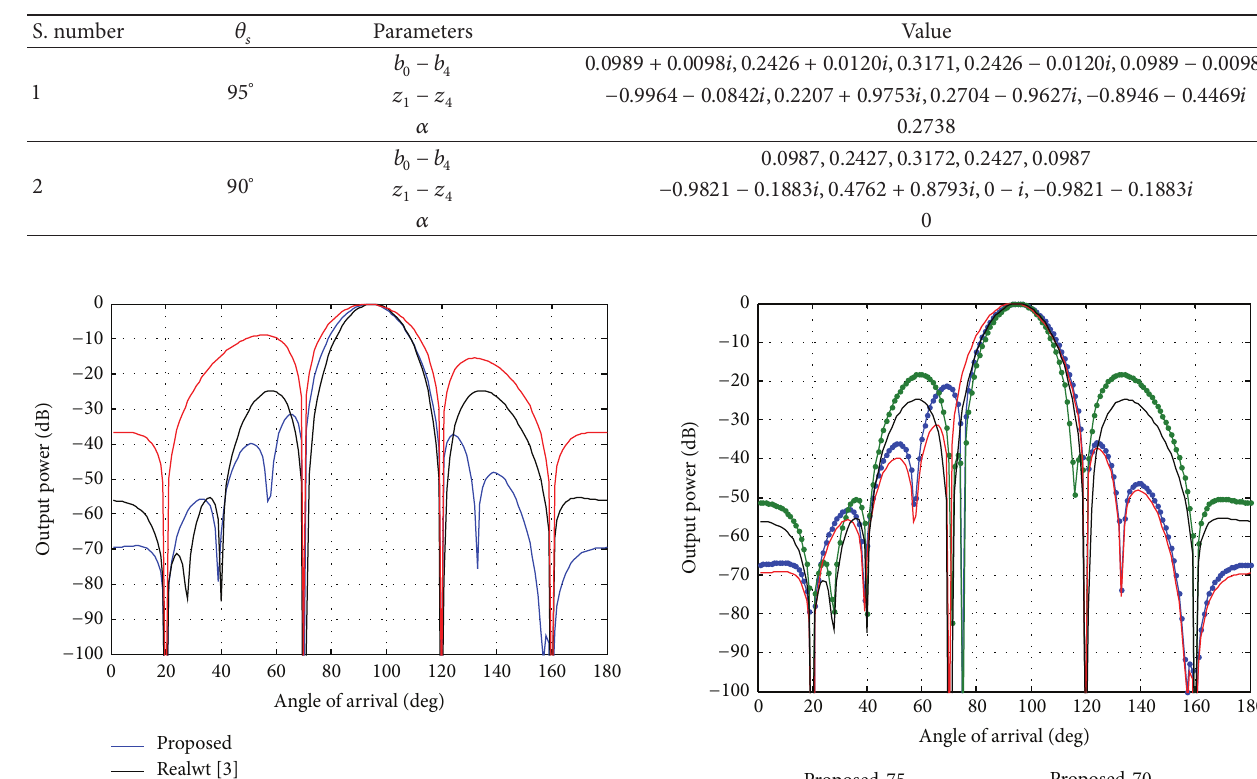
Table 2: Effect of change in 𝜃 𝑠 on different parameters.